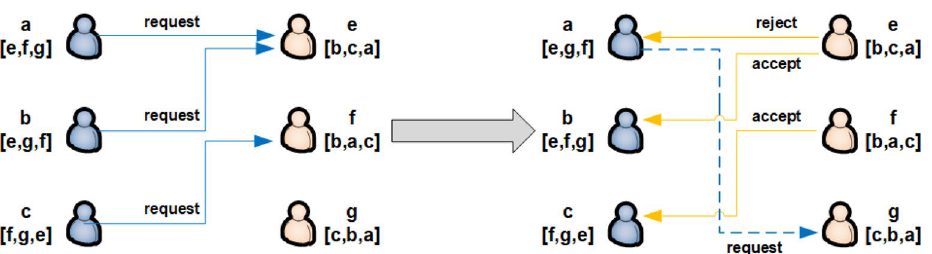
Figure 5. Users { a , b , c } and users { e , f , g } are paired based on the marriage matching model with their selection